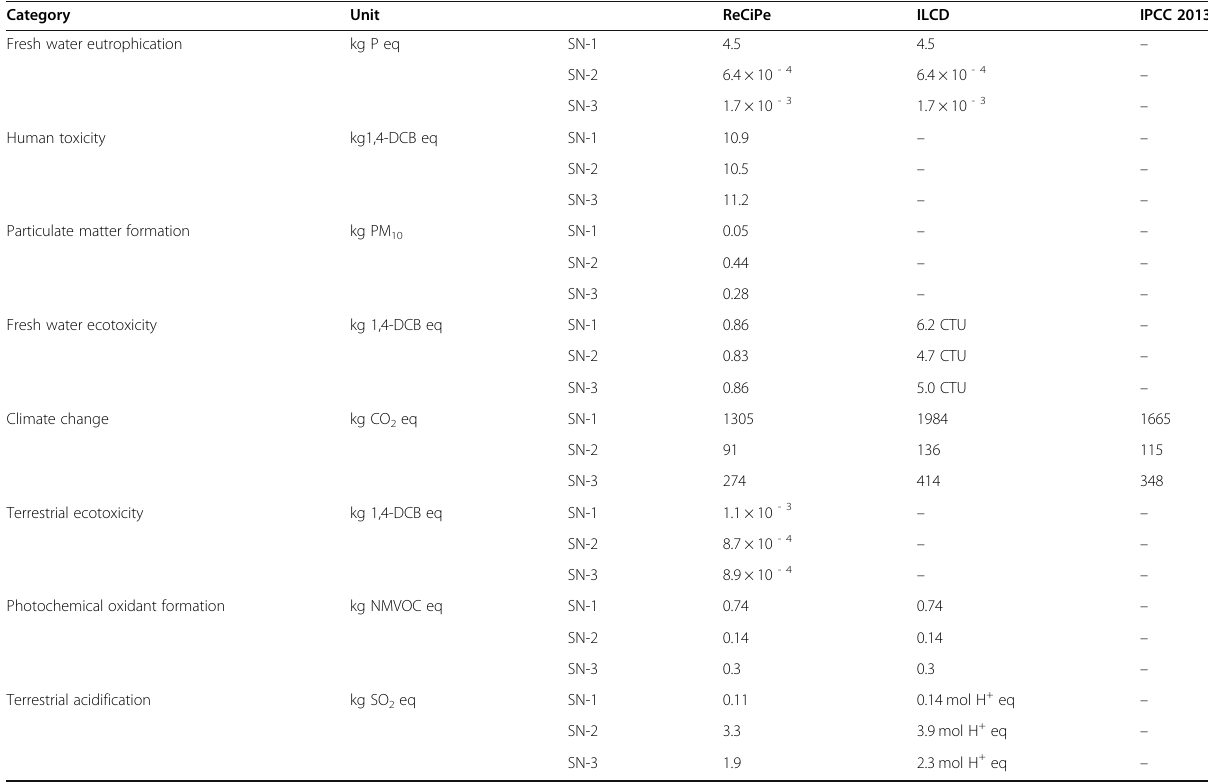
Table 10 Compared ReCiPe 2008 Midpoint (H) V1.13 results with other LCIA methods without resources recovery Category